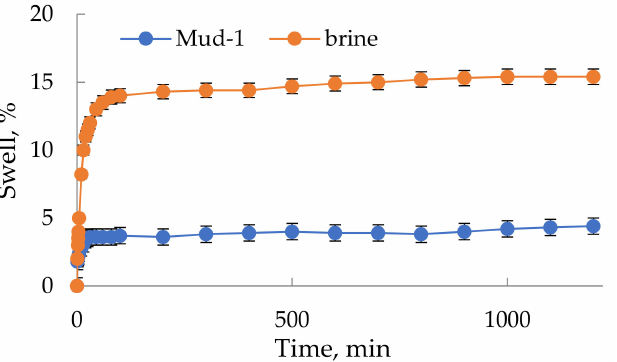
Figure 8. Linear swelling of Miocene shale under the influence of reservoir brine (flowback) and the developed